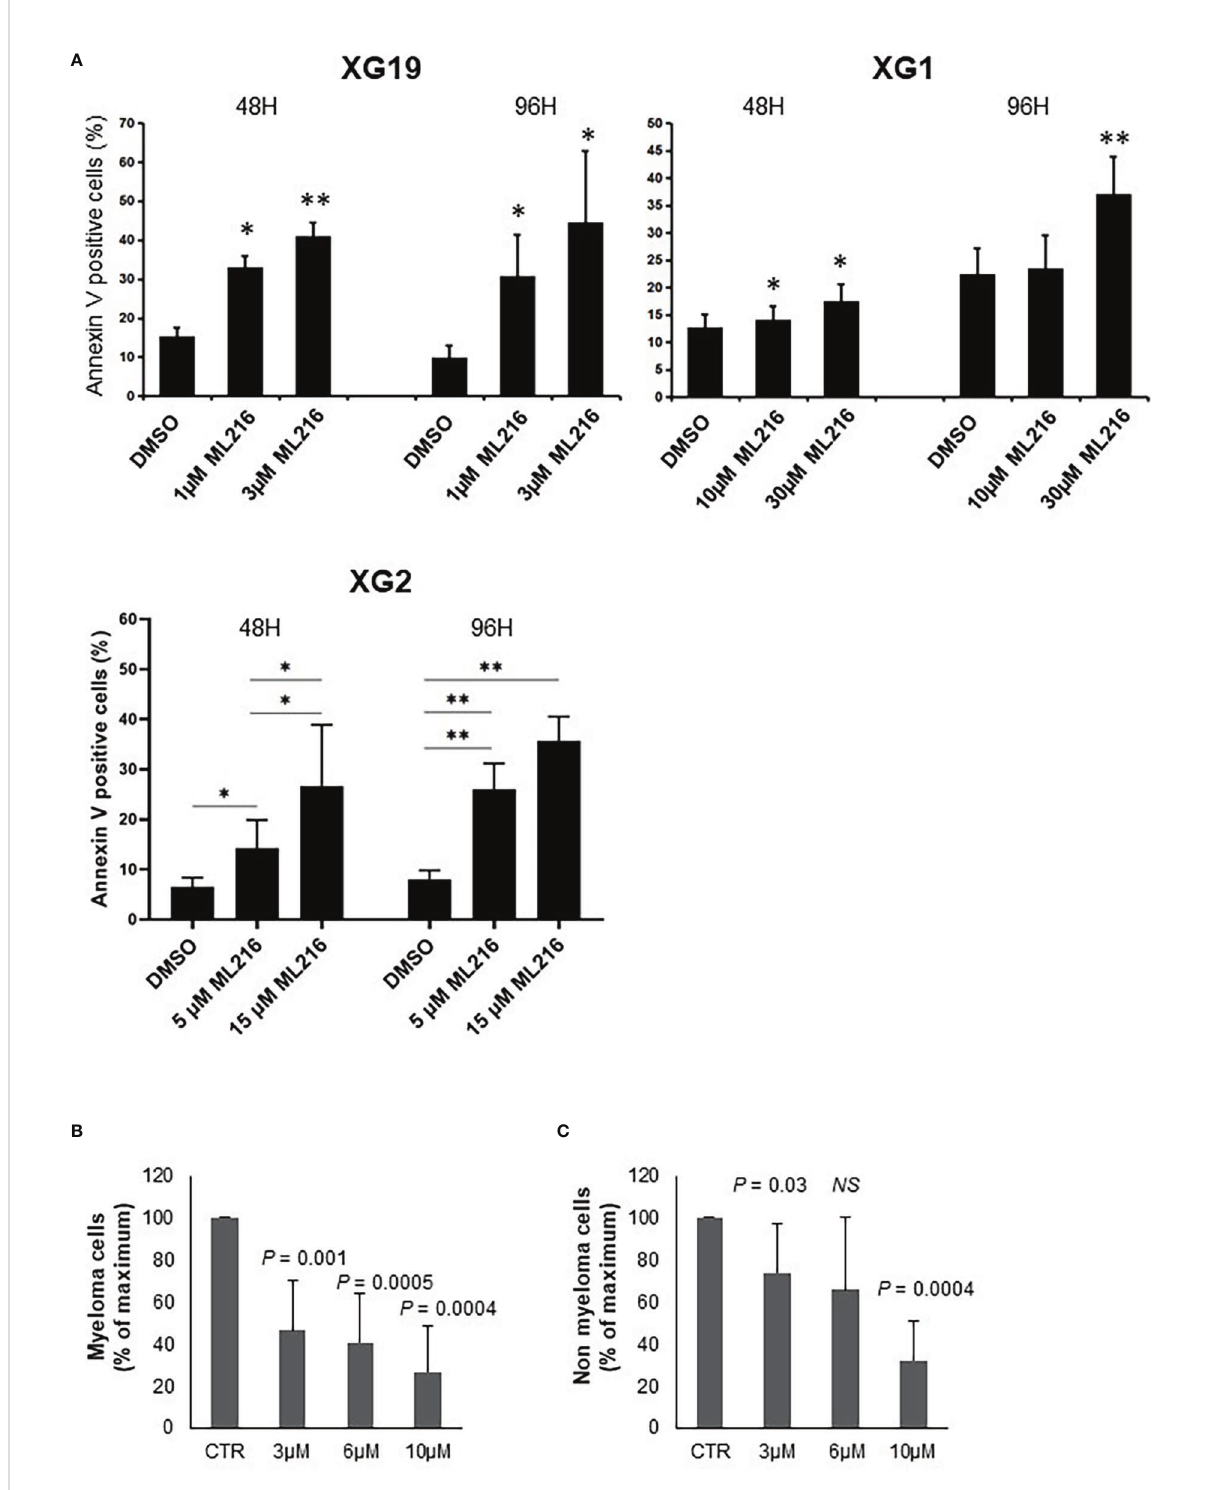
FIGURE 4 ML216 selectively induces apoptosis in MMCs. (A) XG19, XG2 and XG1 cell lines were treated for 48 and 96 hours with the indicated concentrations of ML216. Apoptotic cells were detected as Annexin V+ cells by fl ow cytometry. Results are the average of 3 independent experiments. * indicates a signi fi cant increase in apoptosis compared to DMSO controls using a Student ’ s t-test. (B, C) BM cells extracted from 7 MM patients were cultured with recombinant IL-6 and 3, 6 or 10 m M ML216 for 96 hours. Cytotoxicity was assessed by fl ow cytometry. (B) MM plasma cells (CD138+) were detected using an anti-CD138 antibody and (C) all CD138- cells were analyzed as non-myeloma cells. Number of cells in each condition was normalized with respect to the control. P-values indicate the signi fi cance of the observed differences after applying a Wilcoxon test for pairs. NS, not signi fi cant. * p-value < 0.05, ** p-value <